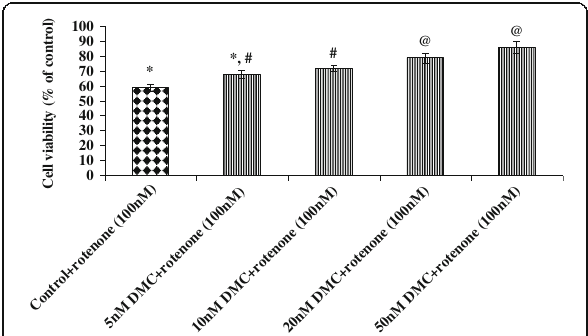
Fig. 3 The protective effect of DMC (5, 10, 20 and 50 nM) against rotenone induced cell death was determined by MTT assay. Values are expressed as the percentage of the untreated control and represented as mean ± SEM of four independent experiments in each group. Values not sharing a common superscript are significant with each other ( p <0.05)